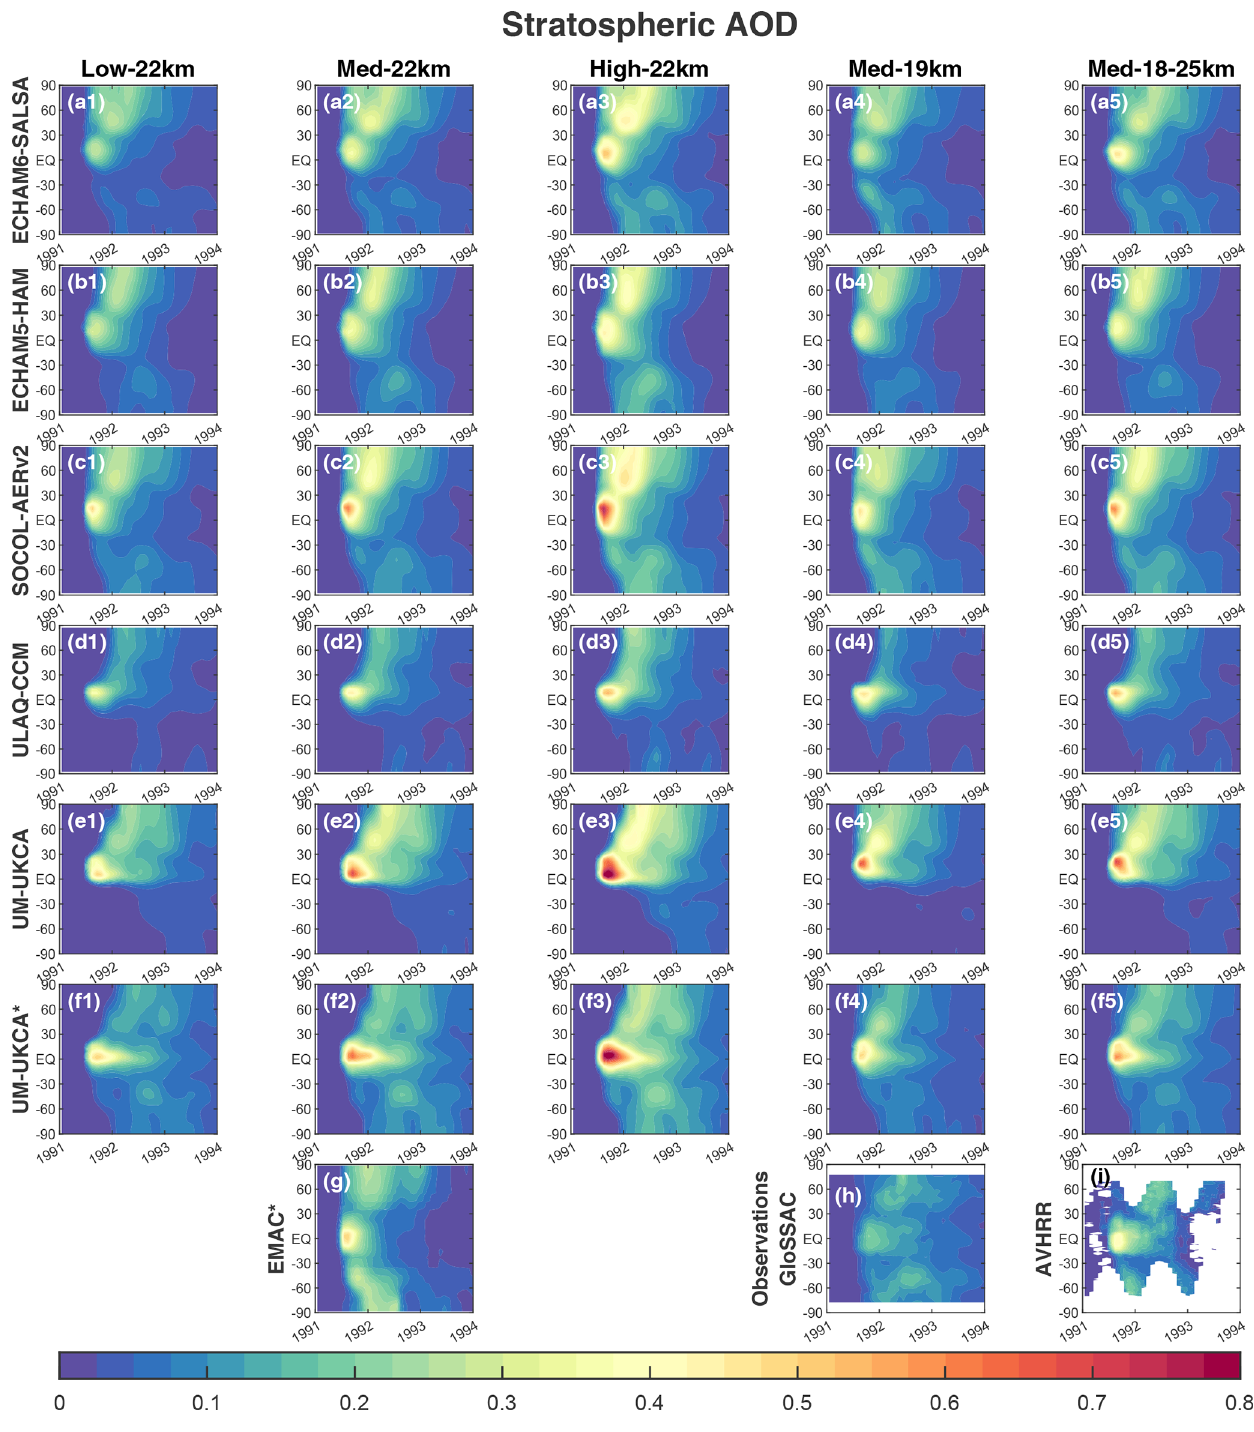
Figure 2. Time evolution of zonal stratospheric AOD for all models and in Low-22km (first column), Med-22km (second column), High- 22km (third column), Med-19km (fourth column), and Med-18–25km (fifth column). The last row includes the different scenario simu- lated by EMAC ∗ and the two observations used for comparison: GloSSAC and AVHRR. AOD is calculated at a wavelength of 550nm in ECHAM5-HAM, EMAC, ULAQ-CCM, and UM-UKCA; 533nm in ECHAM6-SALSA; 525nm in SOCOL-AERv2; 525nm in GloSSAC; and 600nm in AVHRR. ∗ Models with spatially spread SO 2